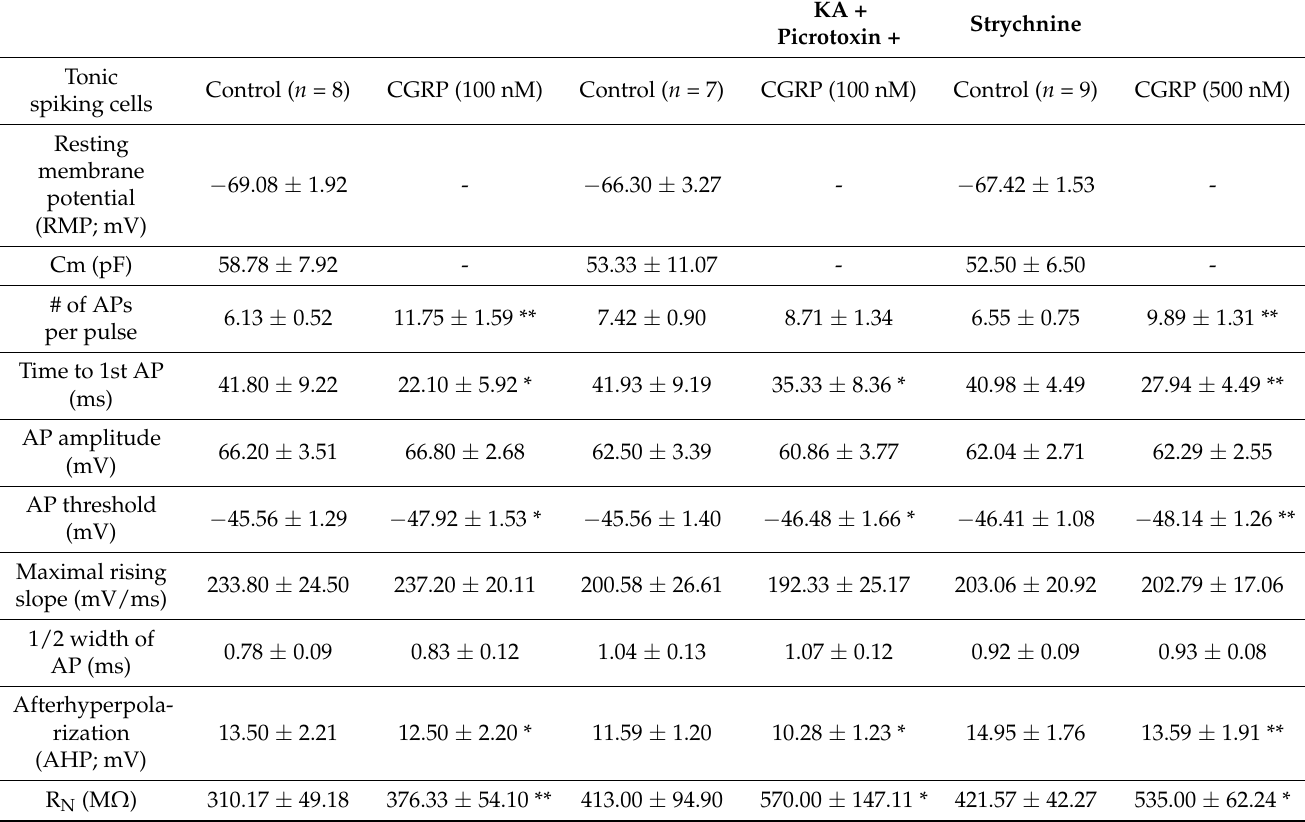
Table 1. Effects of CGRP on the properties of Sp5C superficial laminae cells. Data are presented as mean ± SEM. Except for the resting membrane potential (RMP), membrane properties were characterized based on a holding potential of − 70 mV. The first action potential (AP) responding to the depolarizing current injection (500 ms) was used for analysis. * p < 0.05; ** p <